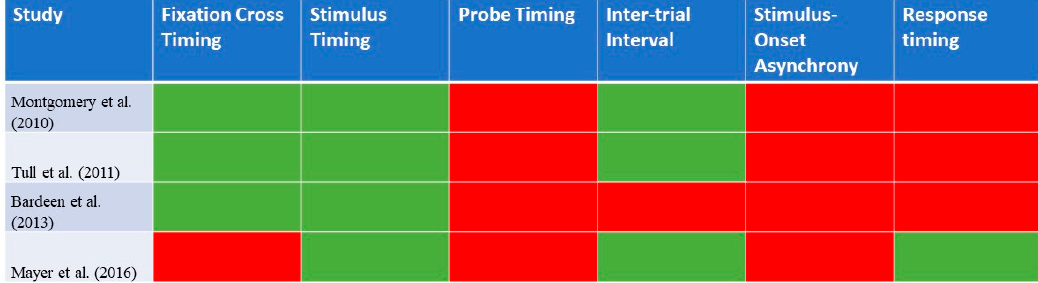
Figure 3. A graphical representation of the details of the Visual Probe Task that were reported in each of the identified studies for stimulant use disorder (n = 4). Green highlights: reported in study; red highlights: not reported in study.